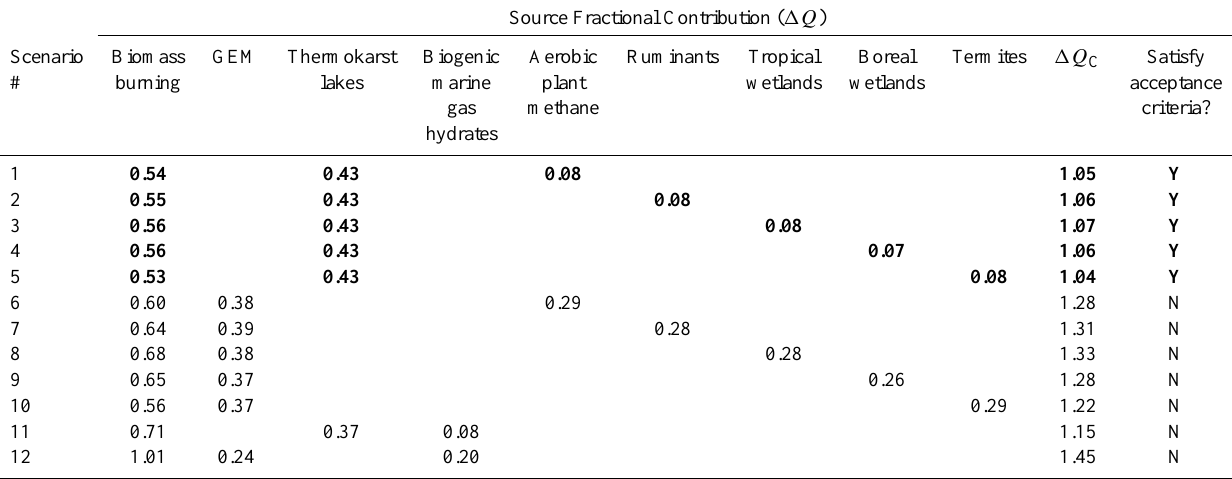
Table 3. Triple isotope mass balance model results for YD-PB source scenarios. Fractional source contributions are calculated simultane- ously via the triple isotope mass balance and compared to the mean ice record δ 13 CH 4 ↑ T , δ D-CH 4 ↑ T and 14 CH 4 ↑ T values for scenario acceptance. All valid scenarios (bold font) pass the acceptance criteria outlined in the text. Solutions with negative emissions are physically meaningless and are listed in Table S4 in the